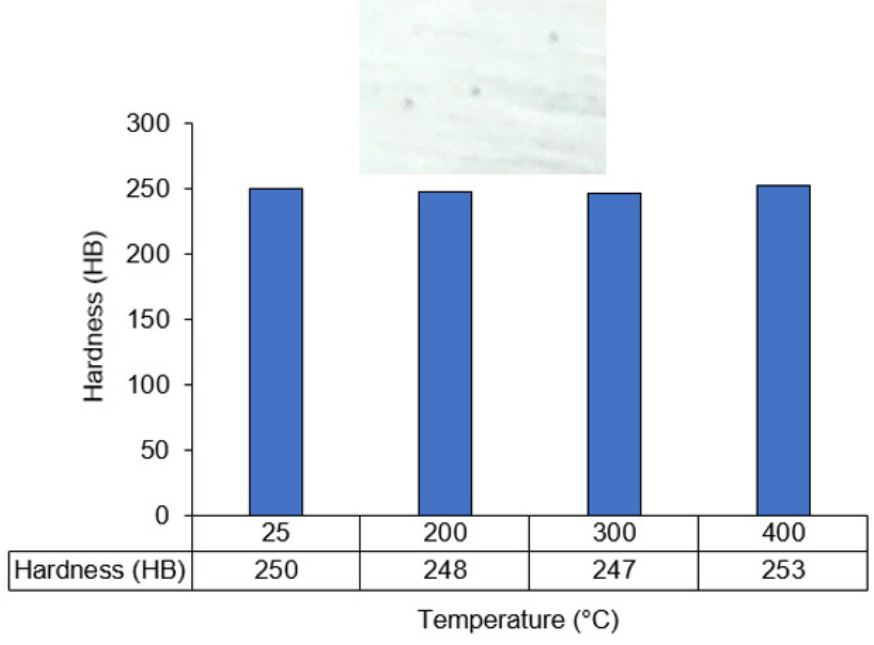
Figure 5. Workpiece hardness after heating at different temperatures and natural